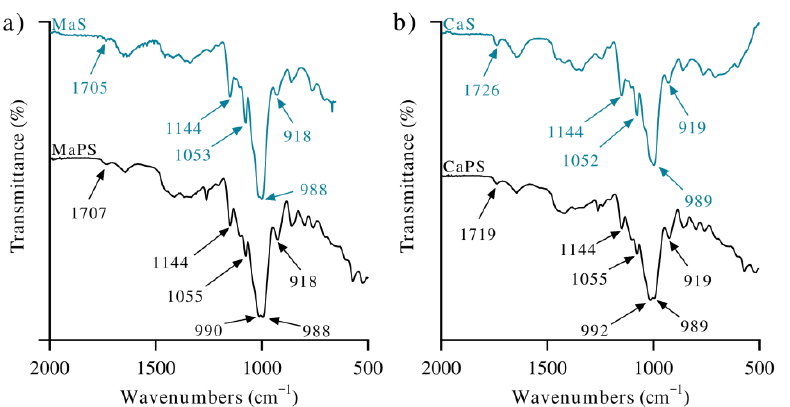
Figure 1. Infrared spectra of ( a ) native corn starch (MaS) and plasticized corn starch with 30 wt% glycerin (MaPS) and ( b ) native cassava starch (CaS) and plasticized cassava starch with 30 wt% glycerin (CaPS).